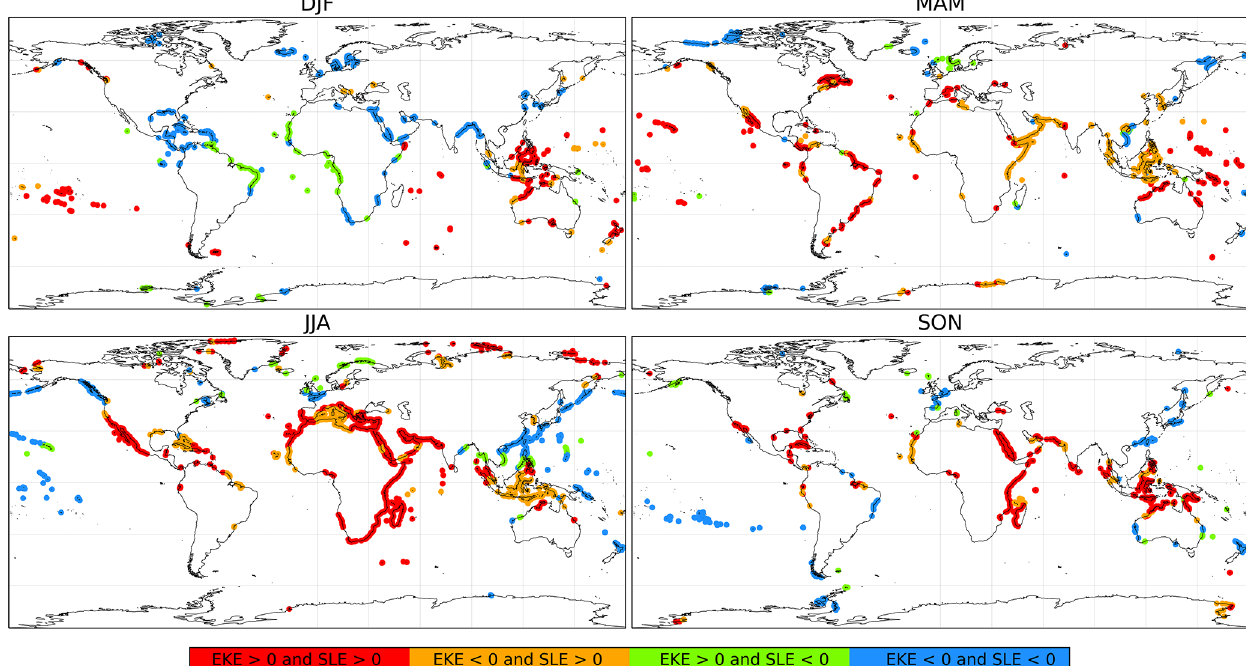
Figure 5. Agreement and disagreement in the sign of anomalies (LIG minus PI) in eddy kinetic energy (EKE) and sea level extremes (SLE). Colors indicate where anomalies in both EKE and SLE are positive (red), where EKE anomalies are negative and SLE anomalies are positive (orange), where EKE anomalies are positive and SLE anomalies are negative (green), and where anomalies in both EKE and SLE are negative